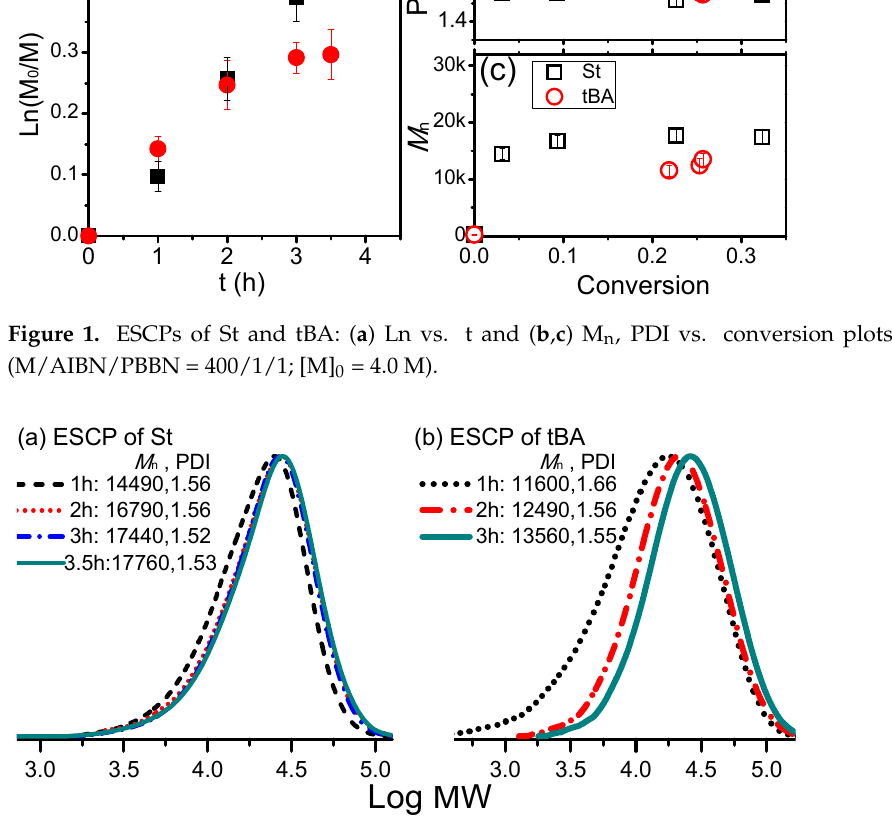
Figure 2. GPC traces of ESCPs of ( a ) St and ( b ) tBA corresponding to Figure 1 (M/AIBN/PBBN = 400/1/1 at 80 °C; [M] 0 = 4.0 M).